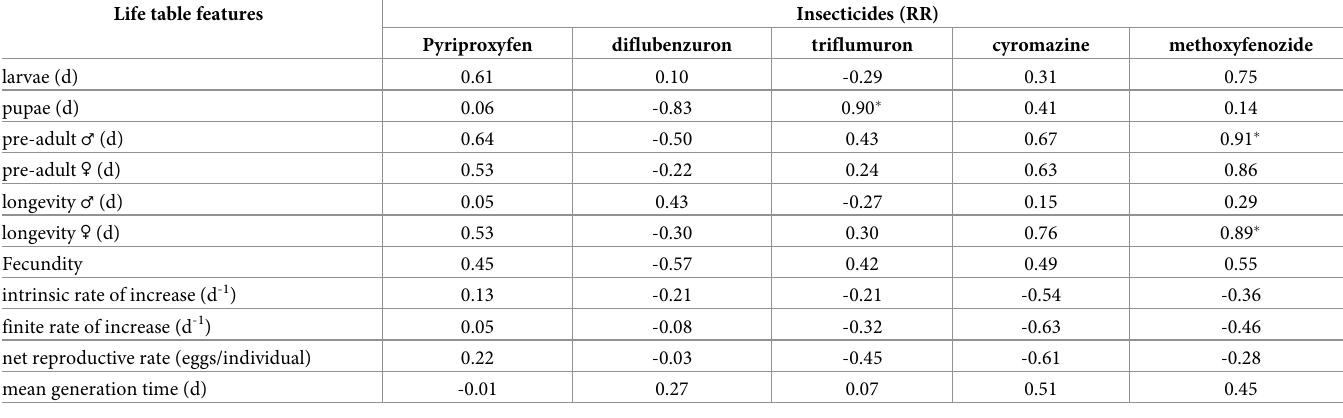
Table 5. Correlation between resistance ratios and life table features of the house fly